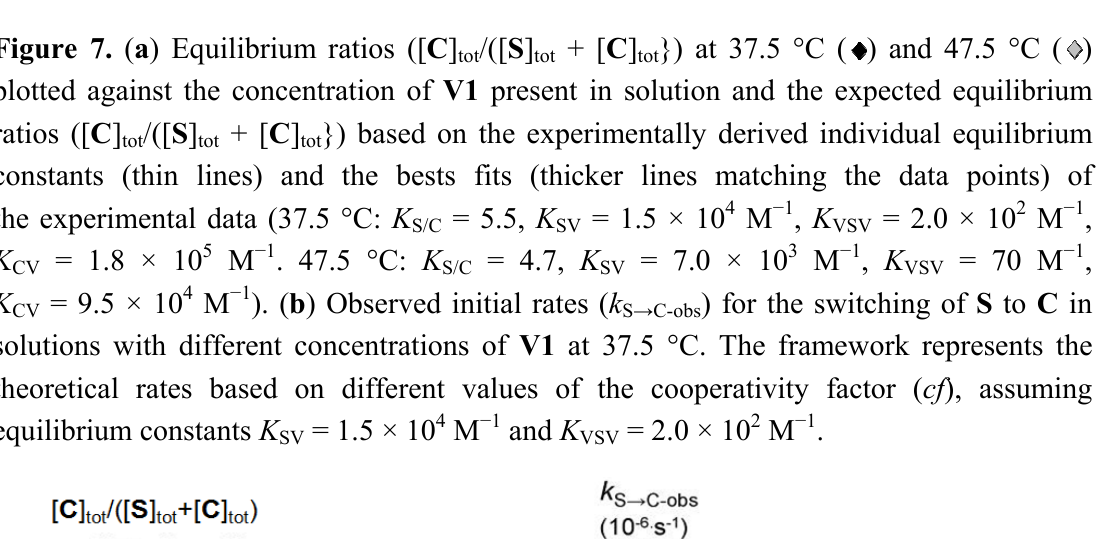
Figure 7. ( a ) Equilibrium ratios ([ C ] /([ S ] + [ C ] }) at 37.5 °C ( ) and 47.5 °C ( ) tot tot tot plotted against the concentration of V1 present in solution and the expected equilibrium ratios ([ C ] /([ S ] + [ C ] }) based on the experimentally derived individual equilibrium tot tot tot constants (thin lines) and the bests fits (thicker lines matching the data points) of = 5.5, K = 1.5 × 10 4 M − 1 , K = 2.0 × 10 2 M − 1 , the experimental data (37.5 °C: K S/C SV VSV K = 1.8 × 10 5 M − 1 . 47.5 °C: K = 4.7, K = 7.0 × 10 3 M − 1 , K = 70 M − 1 , CV S/C SV VSV